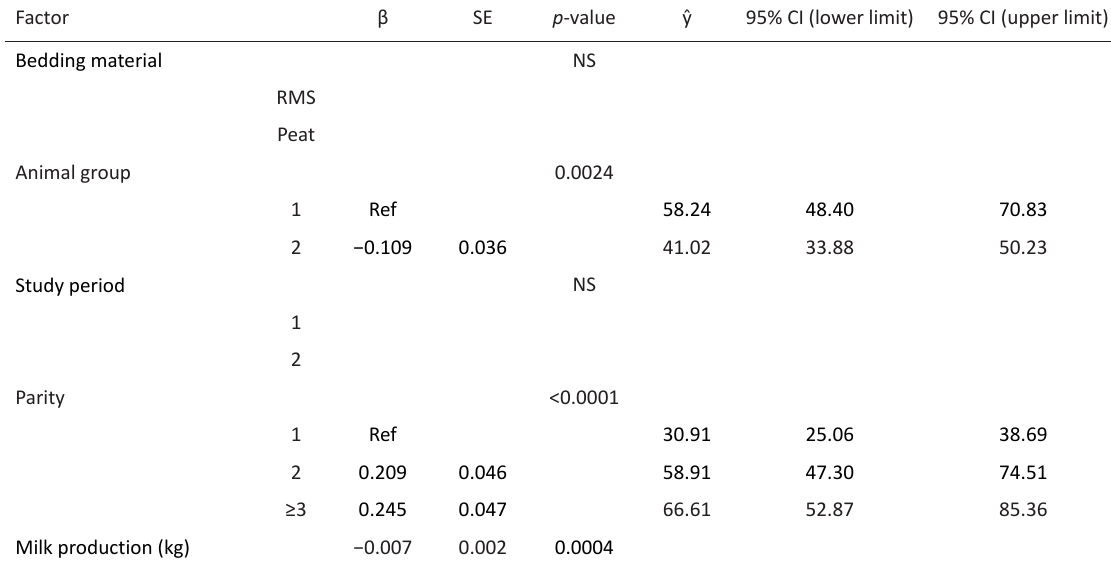
Milk production (kg) β =linear regression coefficient; Ref = reference; ŷ = back transformed least squares